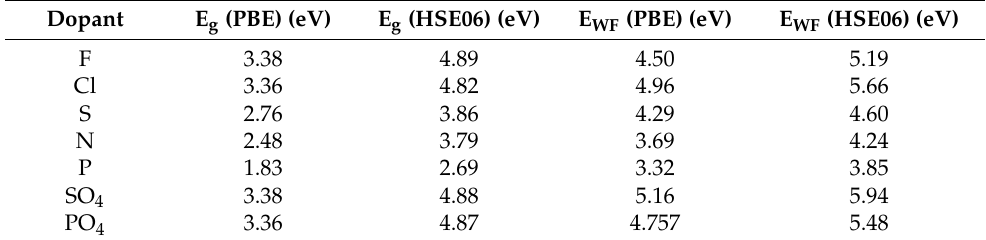
Table 4. Calculated bandgap (E g ) and work function (E WF ) of doped 2D Mg(OH) 2 .